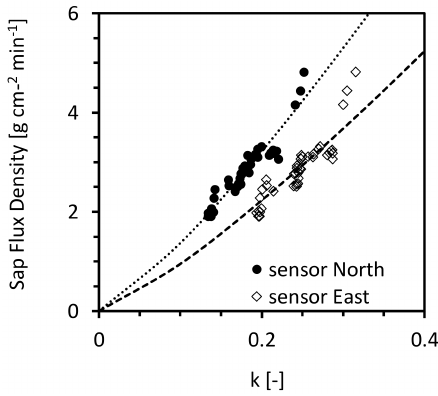
Figure 6. Relationship between the sap flux density and the normalized sensor parameter ( k in Equation